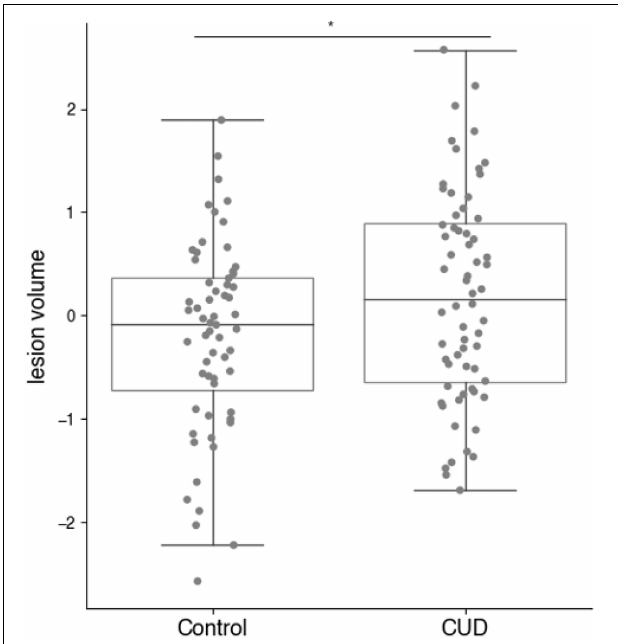
FIGURE 1 | MR derived lesion volumes (normalised) in CUD patients and healthy control participants (full sample n = 124). Lesion volumes were significantly increased in the CUD patients compared with age-and sex-matched control participants (* p < 0.05).